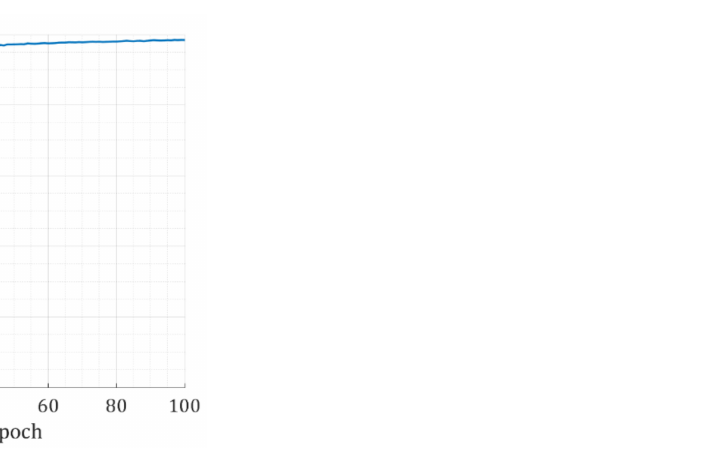
Figure 6. Reward evolution during the TANN learning process for the 7-fiber laser array with 8 correction steps T .